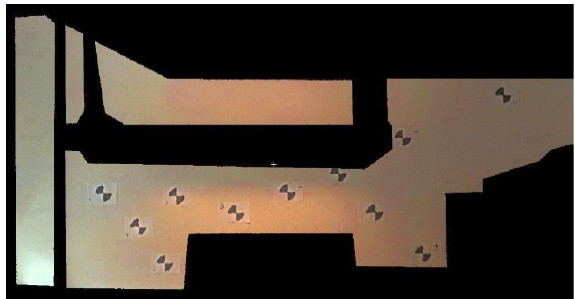
Figure 4. Non-wall points removed for one wall